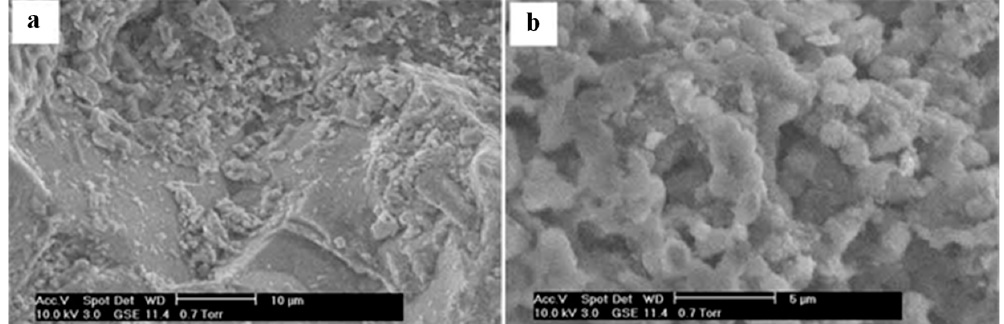
Figure 3. ESEM images of the revived organic coating in a PTYP media (at pH 7) on the surface of pyrite-rich waste rocks from drum in outdoor experiments for 989 days and 4.5 years indoor storage at day one ( a ). After seven days, microbes (cocci) originally present on the rocks were revived and they reformed a coating on the waste rock surface ( b ). Mineral precipitates could also be observed on the rock surface in close association with the microbial cells, suggesting that biomineralization could occur on the microbial cell walls and extra polymeric substances (EPS; ( b )). ESEM observations from University of Ottawa [29].